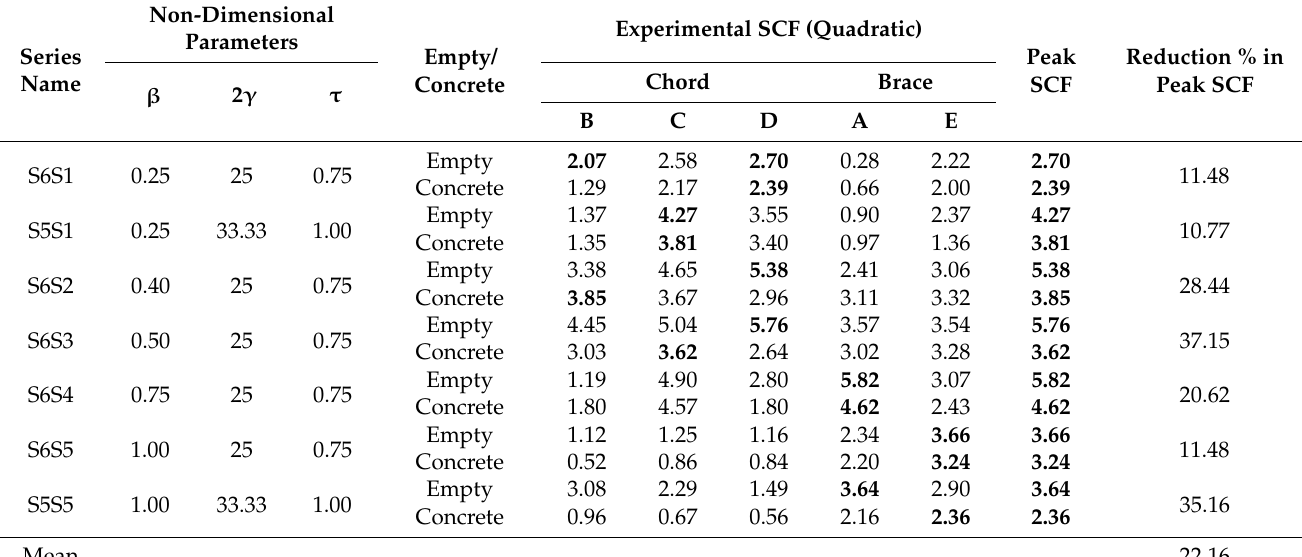
Table 7. Experimental SCFs of concrete-filled T-joints under in-plane